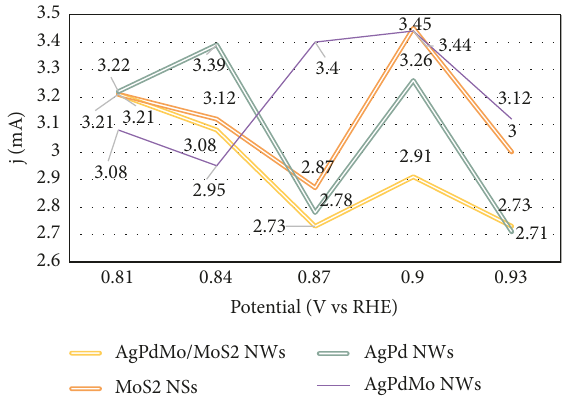
Figure 7: Electrochemical impedance spectroscopy